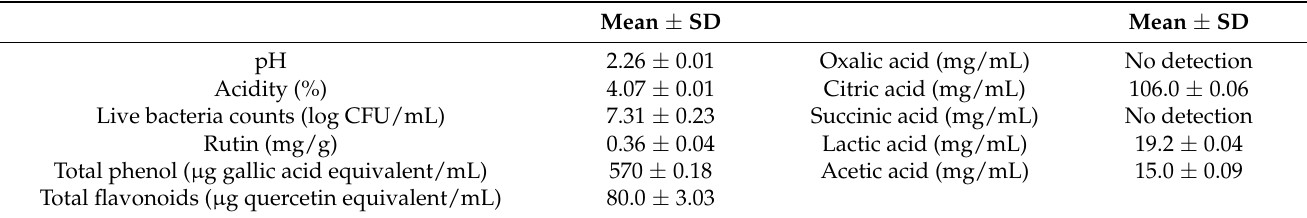
Table 1. Characteristics of fermented mulberry vinegar for nine days. Mean ±